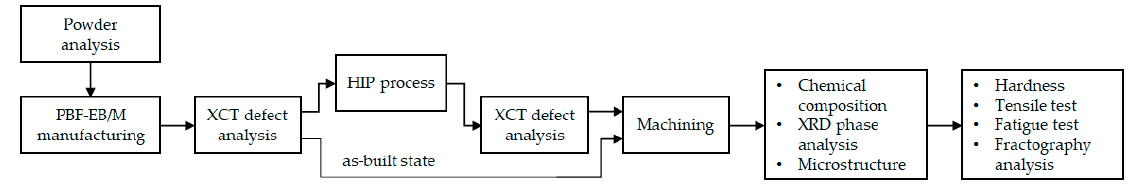
Figure 1. Overview of the methodology. The powder used for this study was formed after the plasma atomization process (APS) (Figure 2), and is characterized by having good sphericity and sparse adhered satellites— characteristic of APS technology. The performed cross-sectional scan of the powder showed no internal pores, no non-metallic inclusions, and no other material defects (Figure 2b).